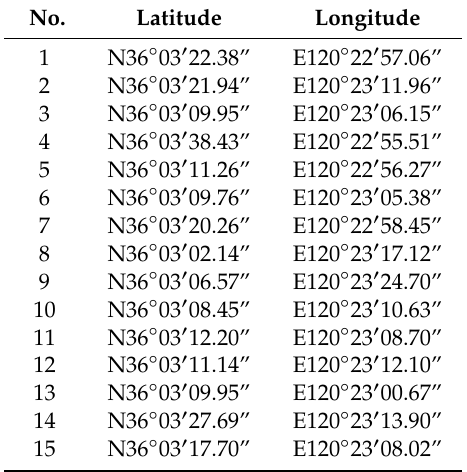
Table A1. Location coordinates of 15 planned points.